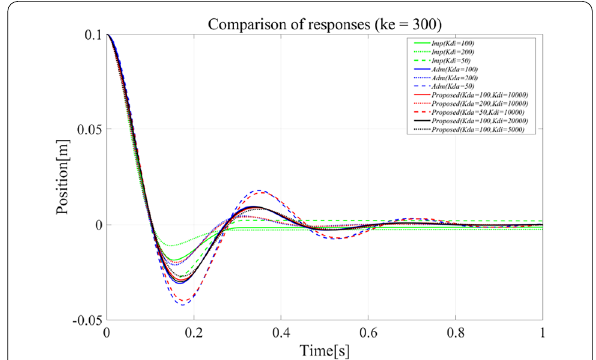
Fig. 5 Transient response of x in k e = 300